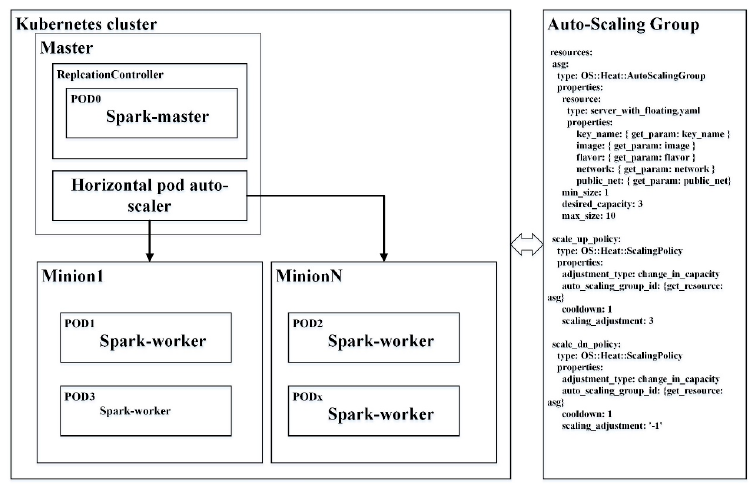
Figure 5. Horizontal auto-scaling containers in OpenStack Clouds for elastic spatial query processing of big spatial data. The left part is a Kubernetes cluster, and the right part is an auto-scaling group, in which kube-proxy and kubelet daemons would run on relevant virtual machines.